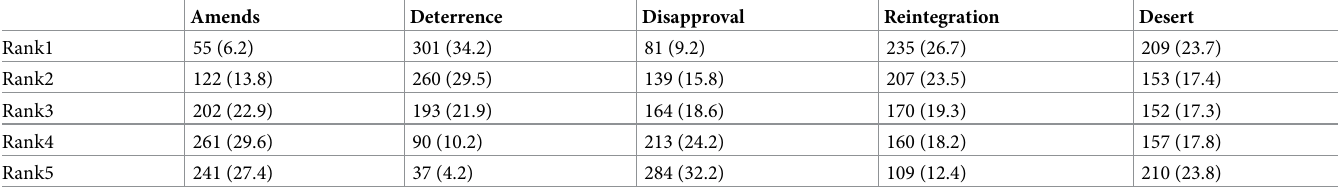
Table 2. Ranking aims of punishment: N and percentage across ranks.